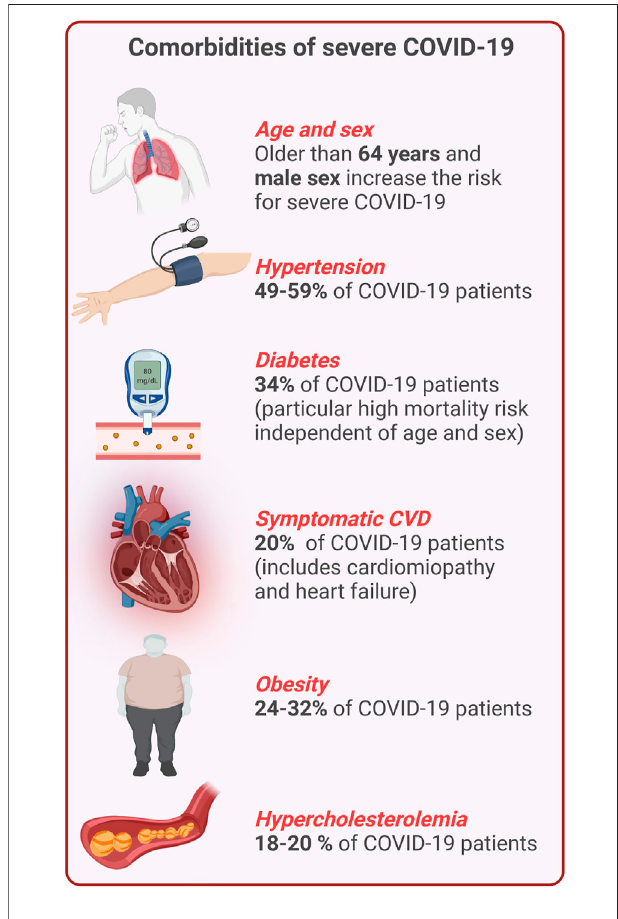
FIGURE 1 | Overview of comorbidities of severe COVID-19 and CVD. Percentages indicate the frequency of certain comorbidities and COVID-19 (This fi gure was made with